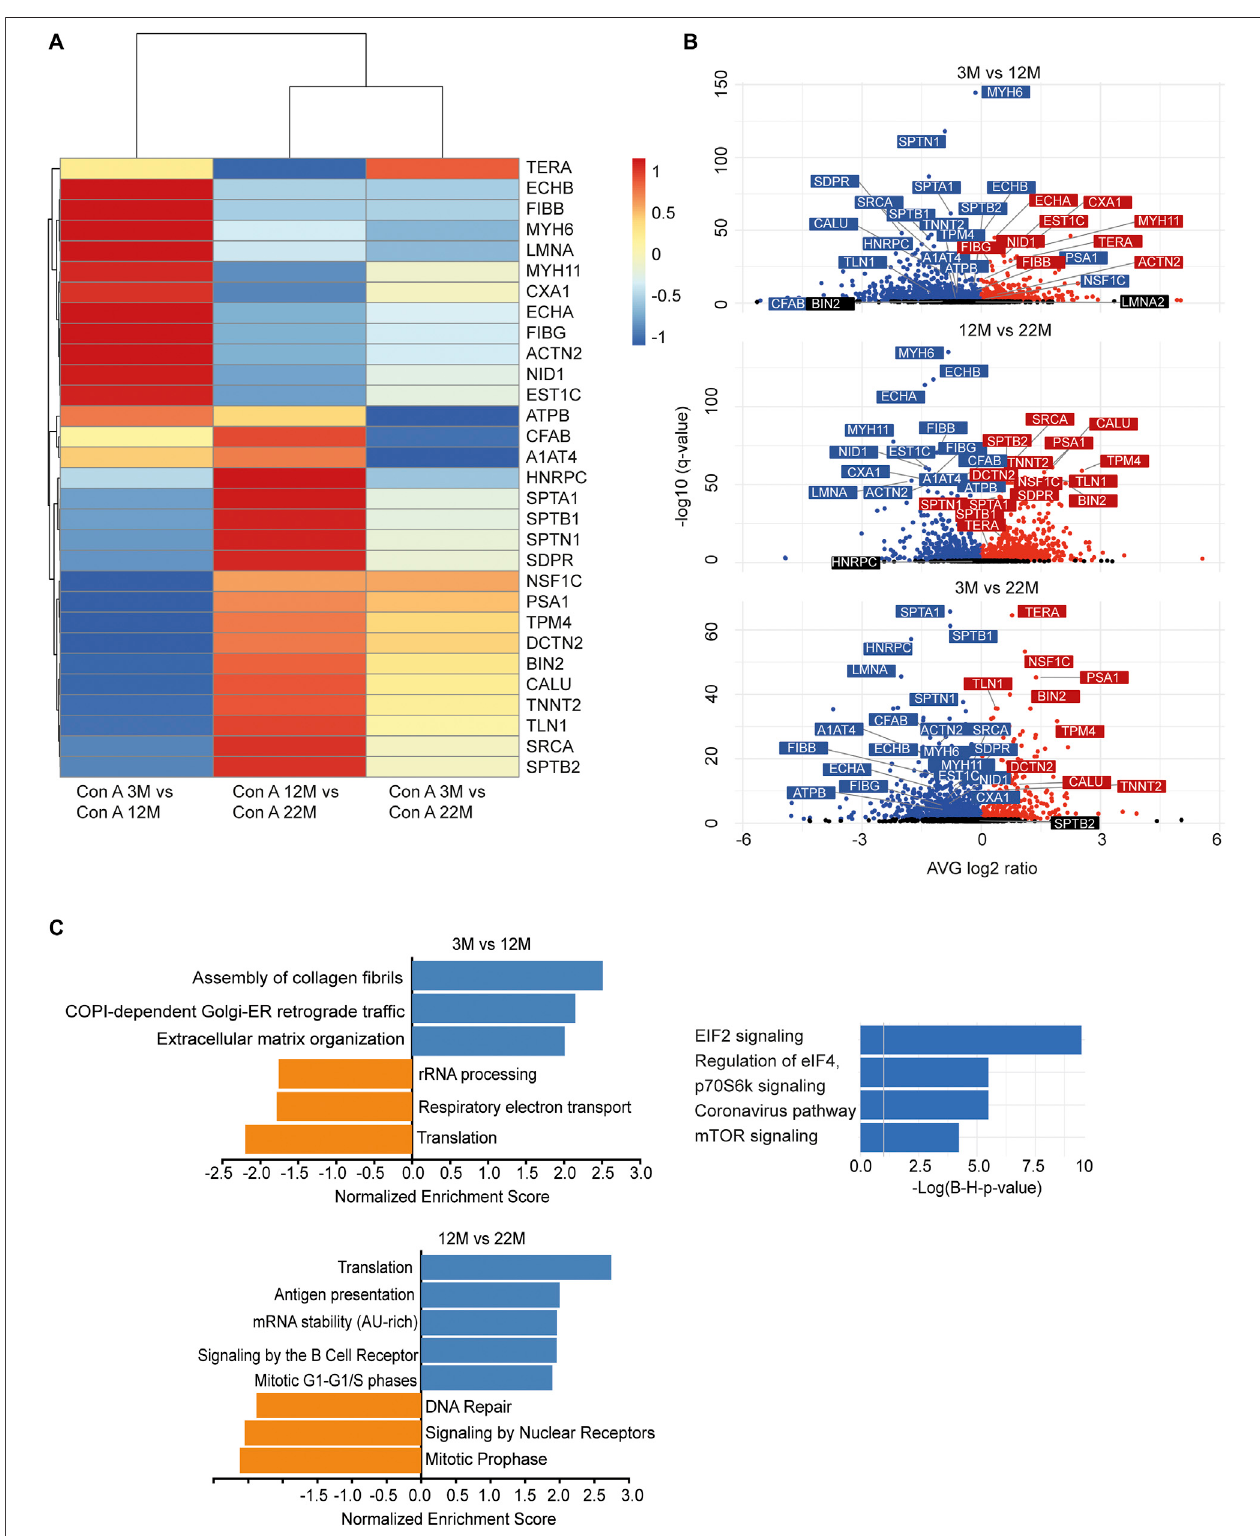
FIGURE 4 | Quantitative changes in the cardiac glycoproteome during aging upon Con A pull-down. (A) Mass spectrometry analysis of top 30 cardiac muscle proteins of aging male mice after Con A pull-down. Proteins signi fi cantly up-regulated/or hyperglycosylated between two different ages are shown in red and those